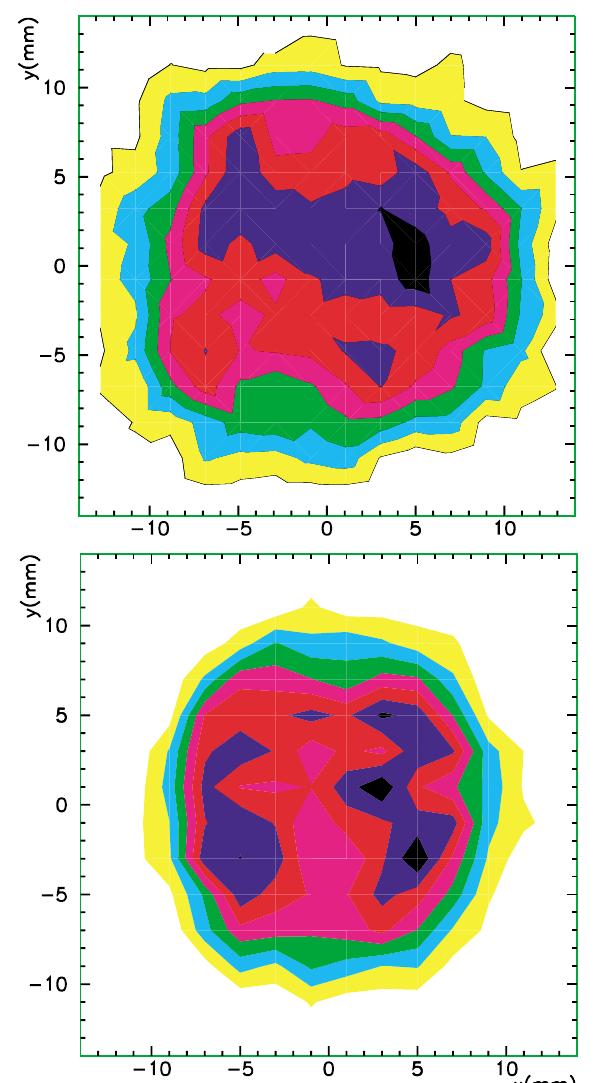
FIG. 10. (Color) Data (top panel) compared to PIC simulation (bottom panel) of the crossed-slit measurement at the d 5 diagnostic station. The contour lines indicate 12.5% increments in relative intensity, and the color code sequence from lowest to highest intensity is yellow, . . .